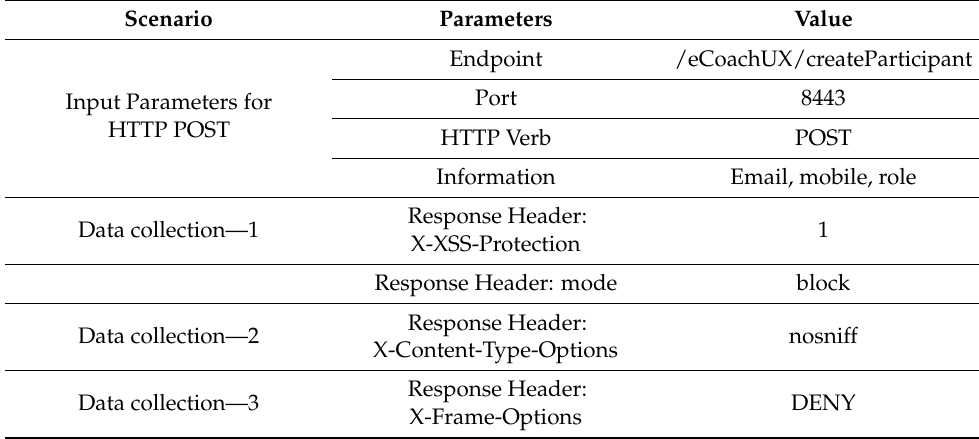
Table 9. Mockito unit testing